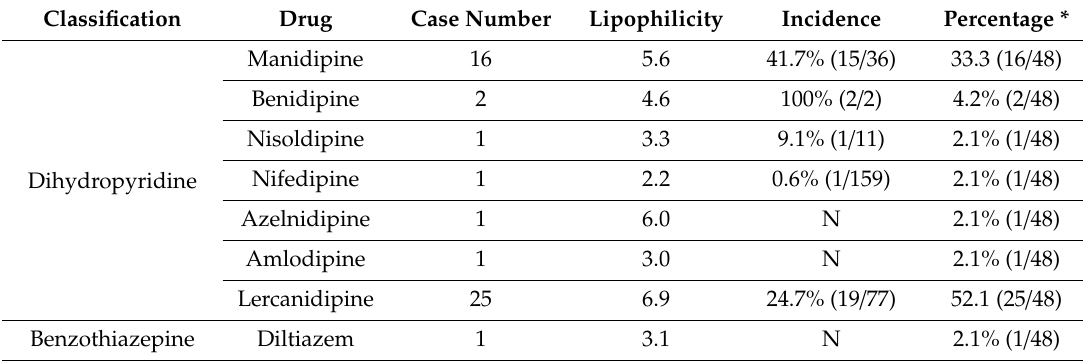
Table 4. The lipophilicity of all calcium channel blocker-associated chylous